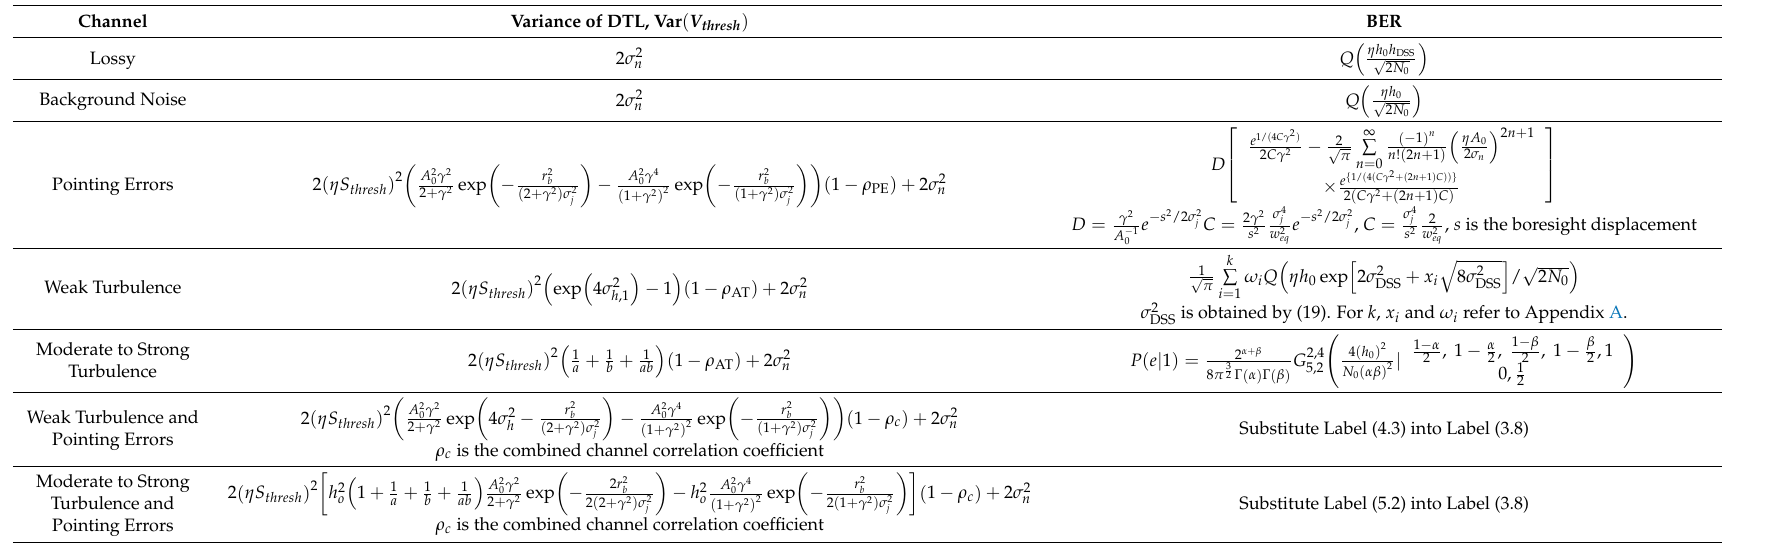
Table 1. Summary of closed-form expressions of the variance of detection threshold level (DTL) and bit-error-rate (BER) for a free space optical (FSO) link under pointing errors under different channel